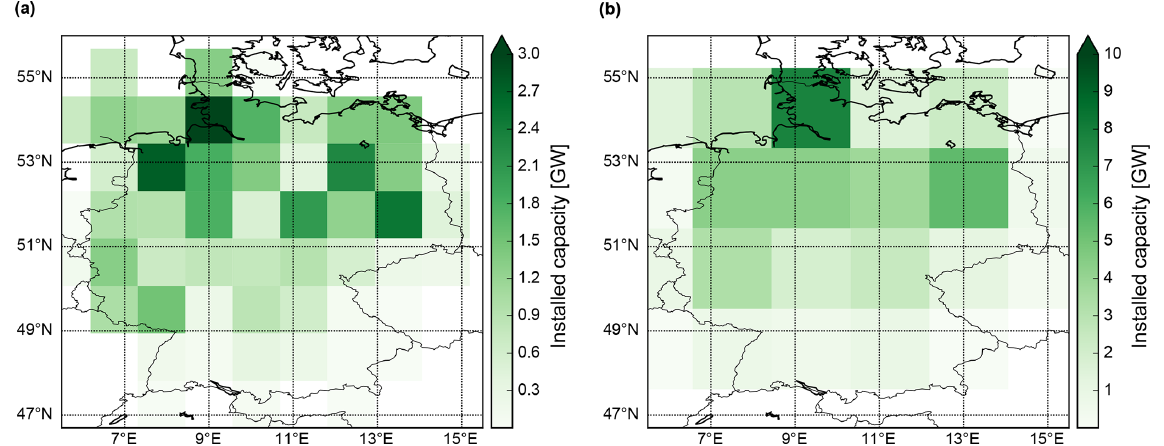
Figure 1. Allocation of turbines based on the Open Power System Data for the end of 2016 (OPSD, 2017). Data are projected on the ERA20C/CERA20C grid (a) and the 20CR grid (b)